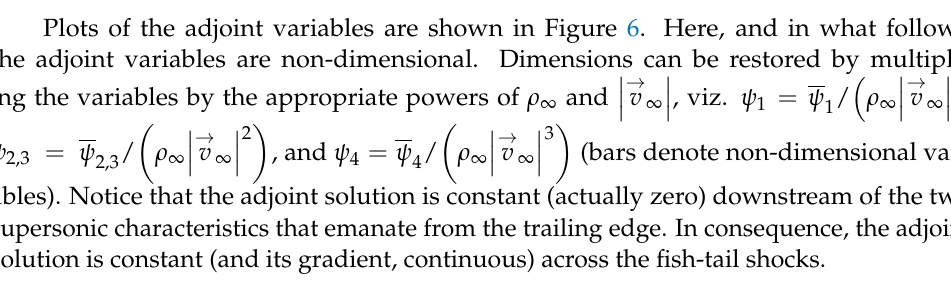
Figure 5. Mach contours and cutting line for flow past a NACA0012 airfoil at M = 1.5 and α = 0°.